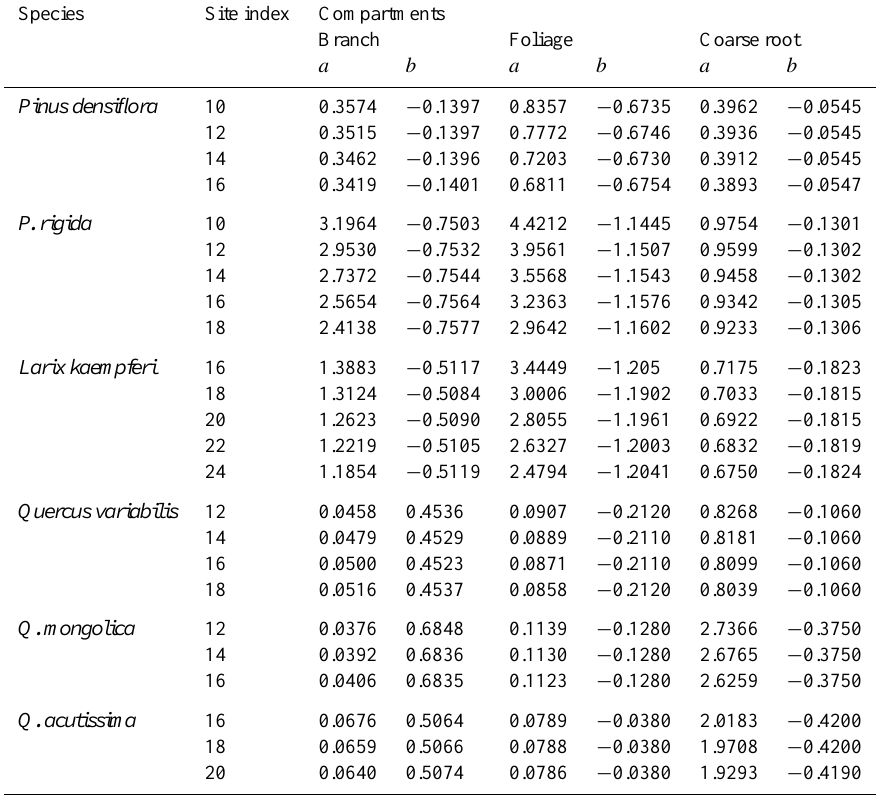
Table B1. The biomass conversion factors (BCFs) for each species by site indices. Multiplying BCFs with C stocks of stemwood, C stocks of other compartments were estimated. The estimation method for the parameters is given in Yi et al. (2013). BCF ( age ) = a · age b